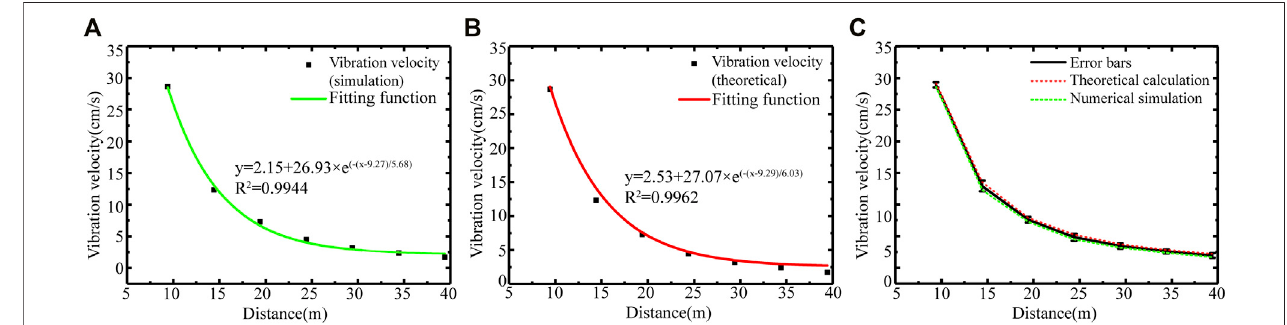
FIGURE 8 | Comparison of blasting vibration velocities. (A) numerical simulation; (B) theoretical calculation; (C) comparison of results.